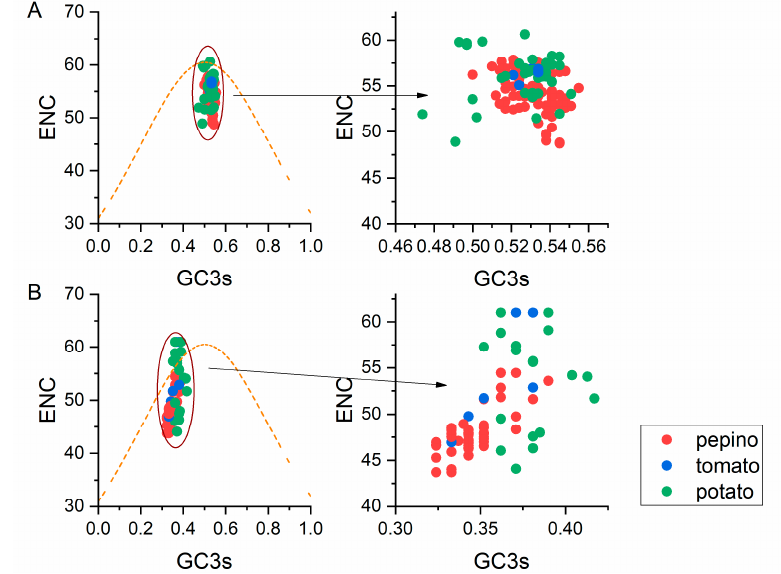
Figure 4. ENC-plot analysis of the CP ( A ) and NABP ( B ) genes of PVM, with ENC plotted against GC3s of different hosts. The orange line represents the standard curve when the codon usage bias is determined by the GC3s composition only. The pepino, potato and tomato hosts are represented by red, green and blue dots, respectively.